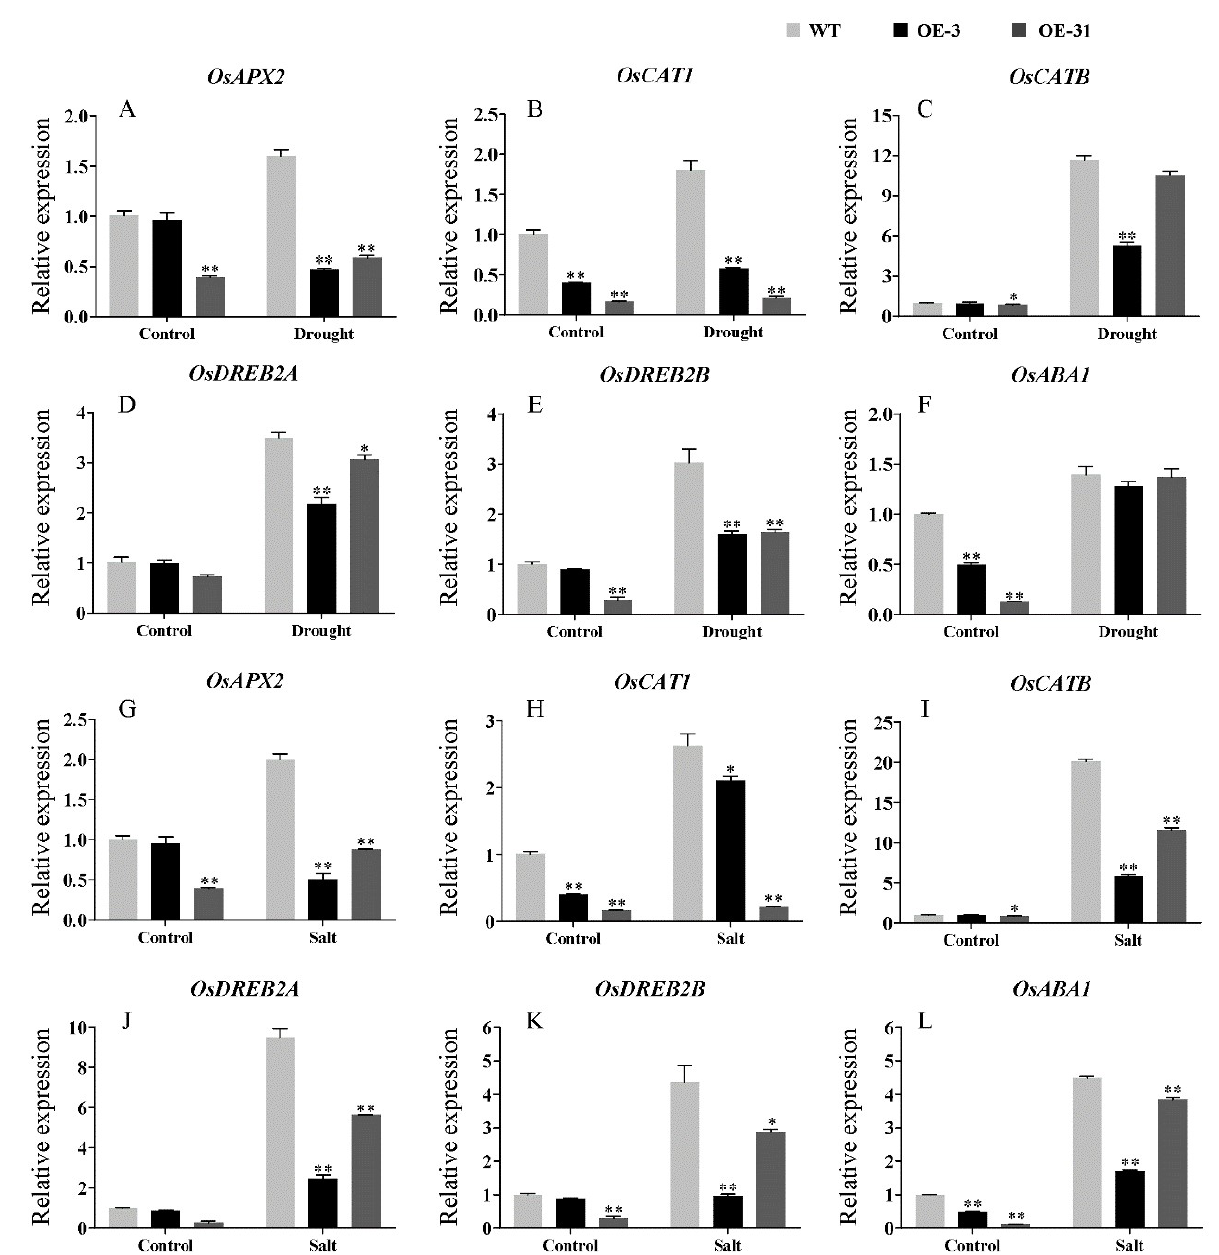
Figure 9. The expression of abiotic stress-related genes in the ZH11 and AcWRKY31 transgenic rice plants in response to drought ( A – F ) and salt stresses ( G – L ). The error bars indicate ± SD ( n = 3 replicates). Asterisks indicate significant differences for the indicated comparisons based on Student’s t test (* p < 0.05, ** p < 0.01).